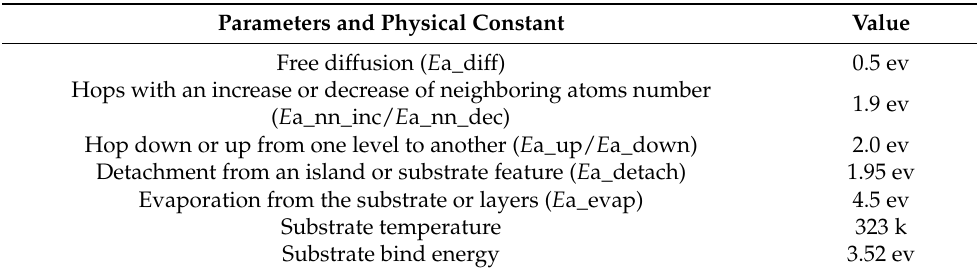
Table 1. The basic parameters of the Si substrate and substrate physical constant.